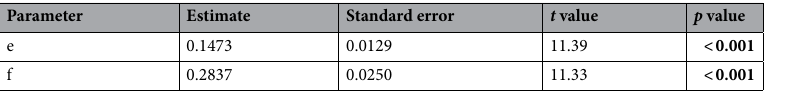
Table 3. Parameter estimates from the power function by least squares method on the relationship of duration and bias (observed species richness of eBird vs. average estimated species richness of BBS). The power function is depicted in Eq. (7) with parameters (e and f) to be estimated. Residual standard error 0.229 on 562 degrees of freedom. Significant parameters are shown in bold.